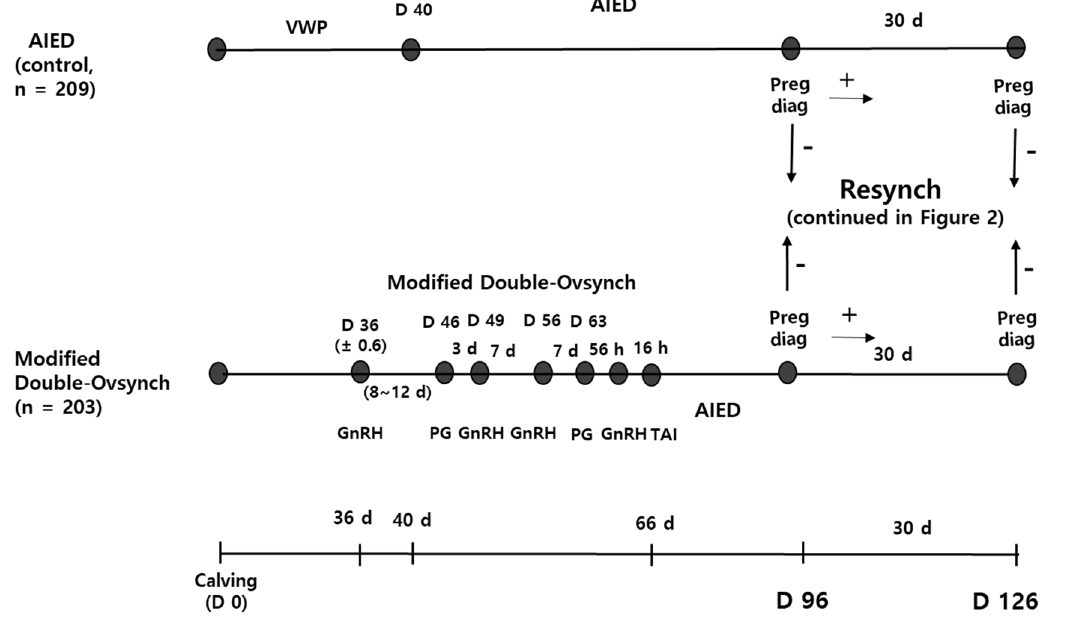
Figure 1. Study design with respect to the first AI following calving and pregnancy diagnosis. AIED, cows underwent AI following estrus detection; modified Double-Ovsynch, Ovsynch, during which the interval of administration of hormones was adjusted according to the herd visit schedule, followed by another Ovsynch 7 days later. AI, artificial insemination; AIED, artificial insemination following estrus detection; VWP, voluntary waiting period; D, day; Preg diag, pregnancy diagnosis; Resynch, resynchronization; GnRH, gonadotropin releasing hormone; PGF timed artificial